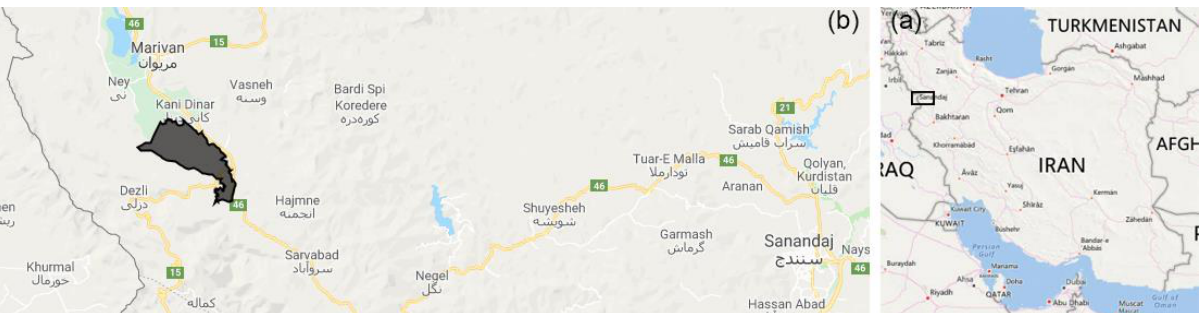
Figure 1. The study area as a black rectangle in (a) and its exact border are presented in a grey